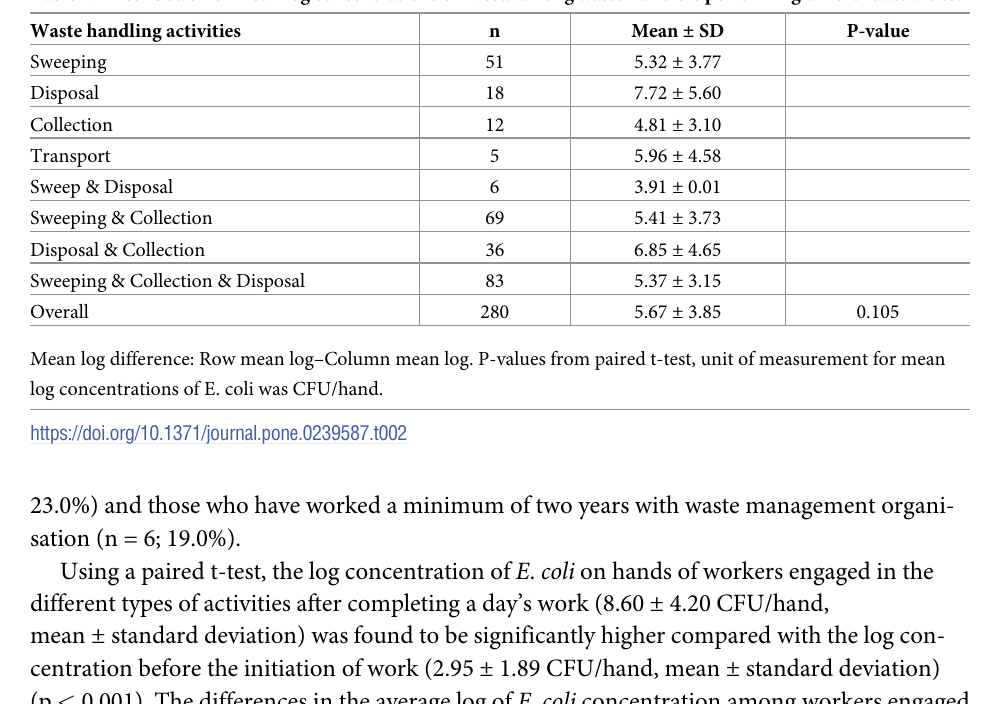
Table 2. Distribution of mean log concentrations of E . coli among waste handlers performing different activities.